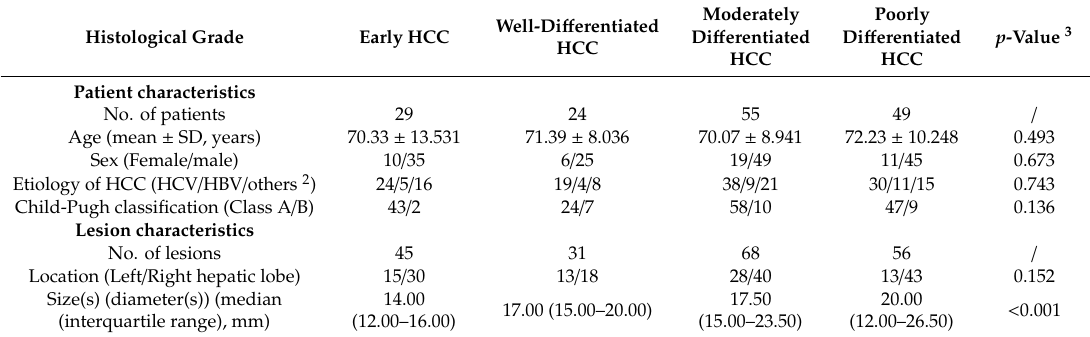
Table 2. Baseline characteristics of the enrolled patients and of the lesions 1